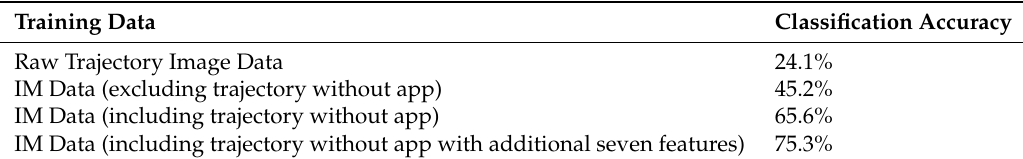
Table 5. Accuracy Comparison